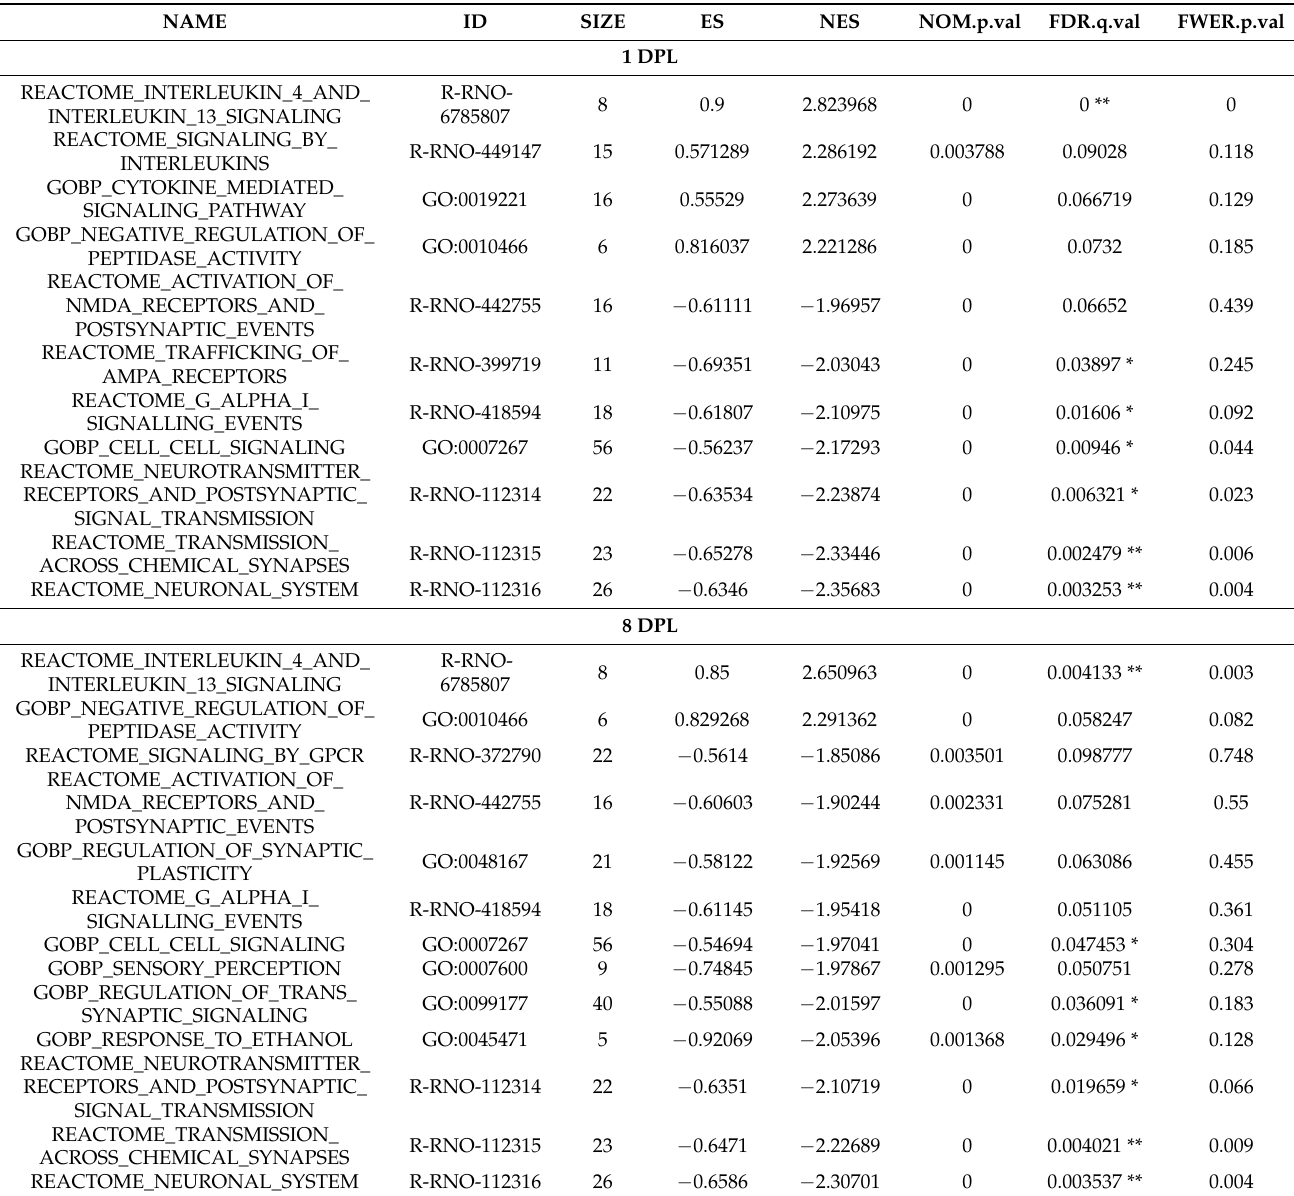
Table 2. Early (1, 8 DPL peak) profiles deregulated pathways in the Spinal Cord segment caudal to the